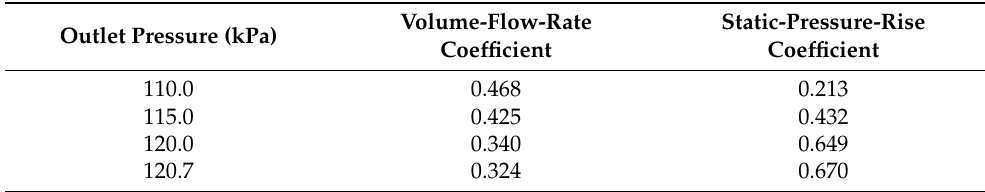
Table 2. Steady numerical simulation performance of the S_A model.